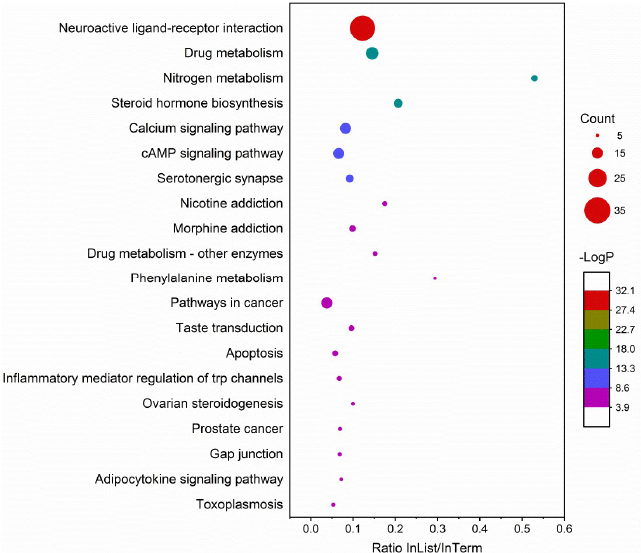
Figure 8. Enrichment analysis on KEGG pathways that demonstrates the representative top 20 en- riched terms. Count, the number of input genes that fall into this term; − Log P, the minus of p -value in log base 10; InList/InTerm ratio, the ratio of the gene count in the list that hit the term to the gene count of the total genome of this term.